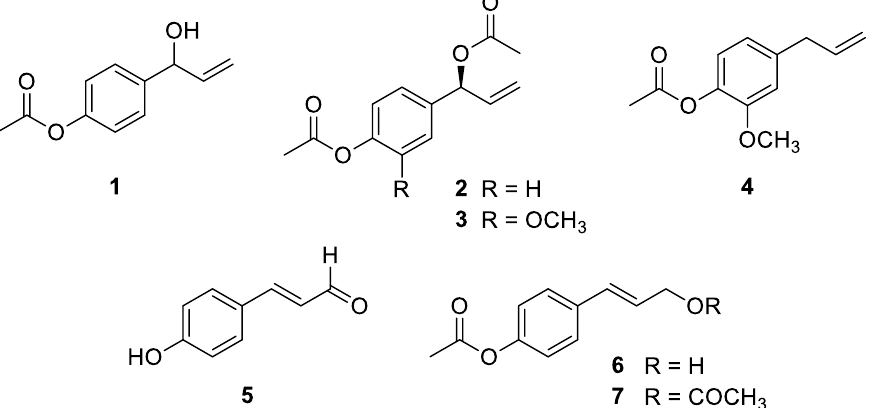
Figure 1. Phenylpropanoids 1 – 7 isolated from the rhizomes of A. galanga . 2.2. Effects of Phenylpropanoids 1 – 7 on Glucose-Stimulated Insulin Secretion